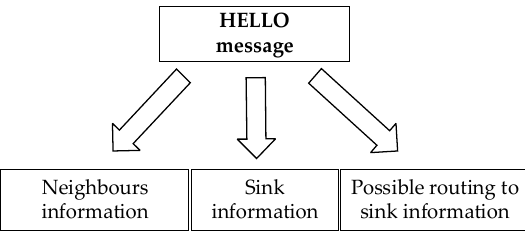
Figure 7. HELLO message format of ER-ATTEMPT protocol.